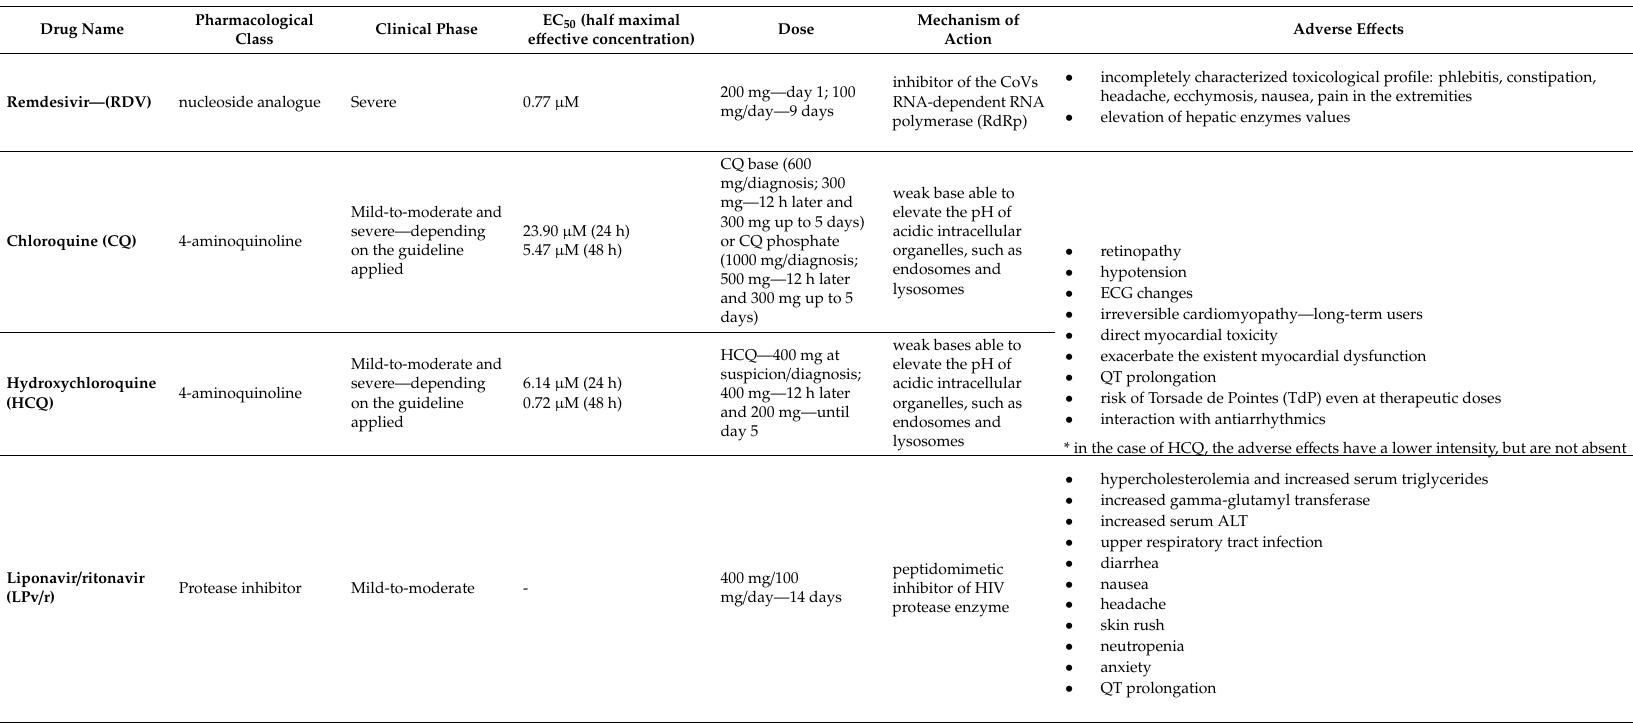
Table 2. Brief description of COVID-19 therapeutic options recommended by World Health Organization (WHO) guidelines